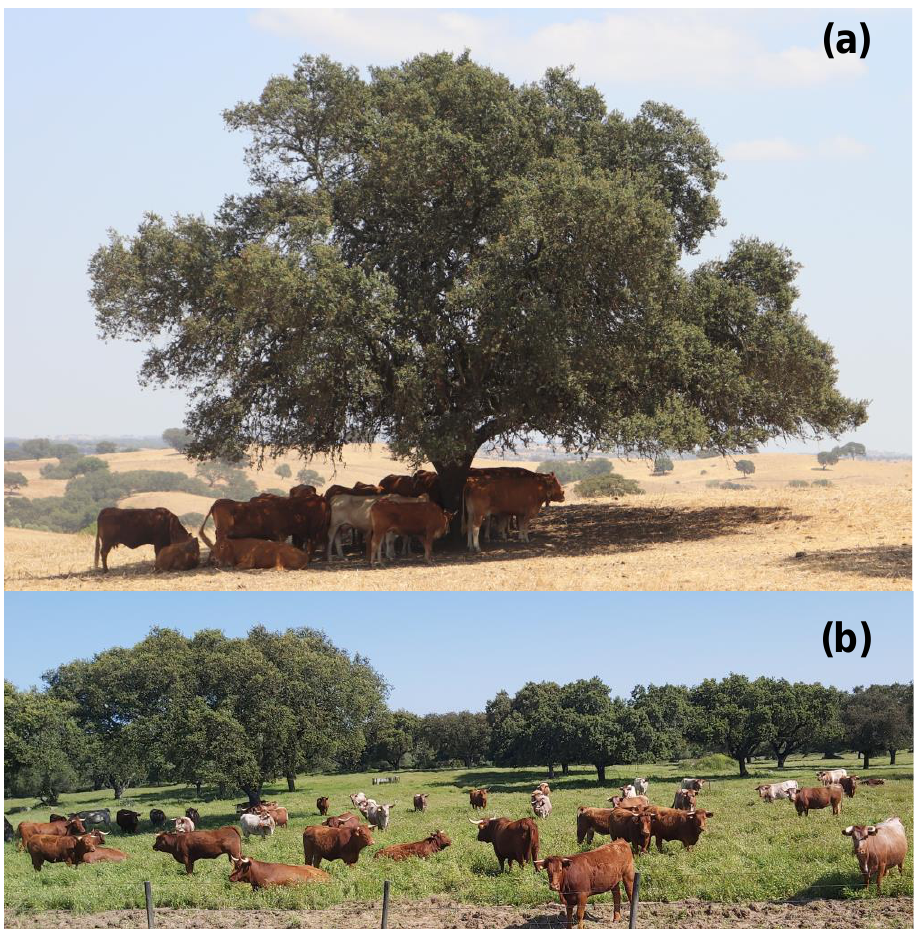
Figure 5. Typical behaviour of grazing cows: ( a ) under tree canopy, UTC, in the hot season (summer); ( b ) in preferential grazing areas in the other seasons (autumn, winter and spring).